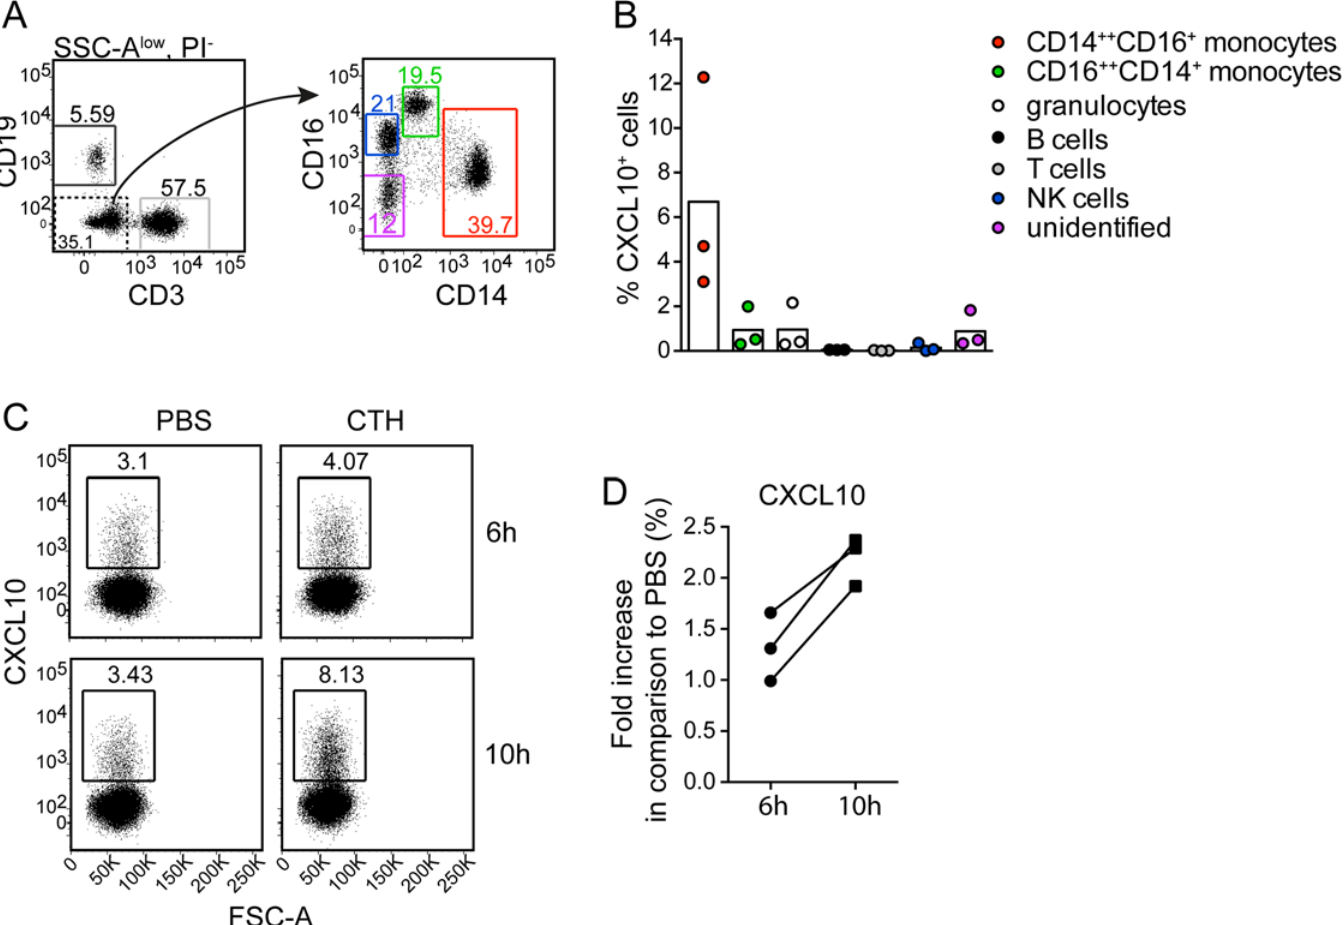
Fig 5. Histones induce CXCL10 production by CD14 ++ CD16 + monocytes. Human PBMCs was stimulated with CTHs (10 μ g/ml), or PBS for 6h or 10h respectively, with Brefeldin A being present during the last 4h of stimulation. Cells were collected and analyzed for intracellular CXCL10. (A) Gating strategy used to identify indicated peripheral blood cellular subsets after exclusion of granulocytes based on high SSC signal (SSC-A high ). Cells with a CD16 + CD14 - phenotype were confirmed to be NK cells based on CD56 expression. (B) Percentage CXCL10 + cells within indicated subsets after 10h of CTH-stimulation. Background (PBS control) is subtracted. Data from three separate experiments are shown. (C and D) CXCL10 expression by CD14 ++ CD16 + monocytes after 6h and 10h stimulation with CTHs or PBS. Representative FACS plots (C) and pooled results, from three separate experiments showing CXCL10 expression in CTH-stimulated cultures relative to PBS control cultures for indicated time-points